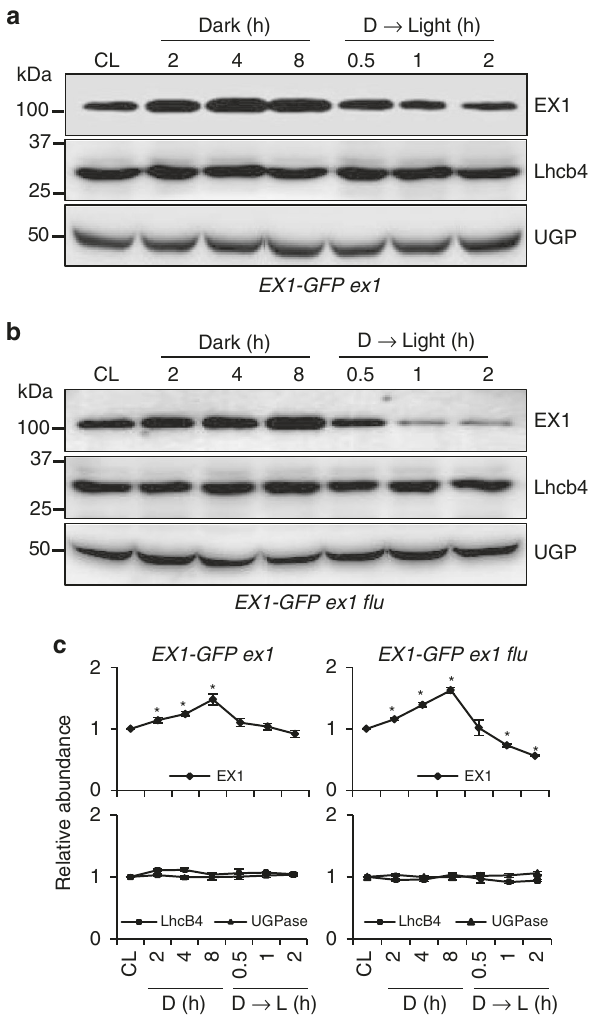
Fig. 1 Light- and 1 O 2 -dependent EX1 degradation. Continuous light (CL)- grown 5-day-(d)-old transgenic seedlings of a ex1 and b ex1 fl u expressing EX1-GFP under the control of the 35S promoter were transferred to the dark (for 2, 4, 8 h) and the 8-h-dark (D)-treated seedlings were re-exposed to light (for 0.5, 1, 2 h) at the light intensity of 100 µ molm -2 s -1 . Total protein was extracted and analyzed by western blot. Chlorophyll a/b binding protein CP29 (Lhcb4) and cytosolic UDP-glucose pyrophosphorylase (UGP) were used as controls. EX1-GFP, Lhcb4, and UGPase were detected using antibodies against GFP, Lhcb4, and UGP, respectively. c The levels of EX1-GFP in the dark or after re-exposing to light were compared to its abundances under CL conditions. Average intensity values of the protein bands were calculated using AzureSpot software v14.0 (AZURE). Data represents the mean of three biological repeats. Error bars show standard error of the mean. Asterisks in c indicate statistically signi fi cant differences to CL condition ( P < 0.05, Student ’ s t